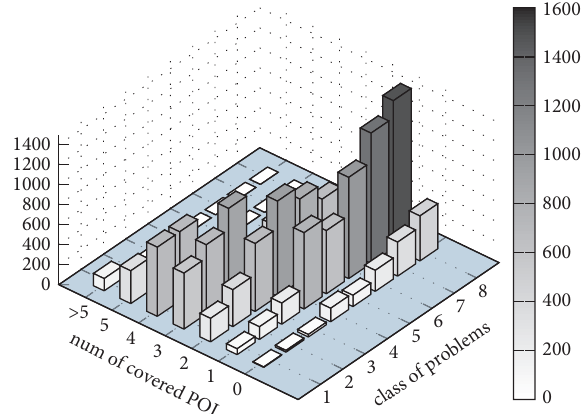
Figure 2: Mean numbers of sensors covering 0, 1, 2, 3, 4, 5, and more than 5 POIs for the eight test cases of